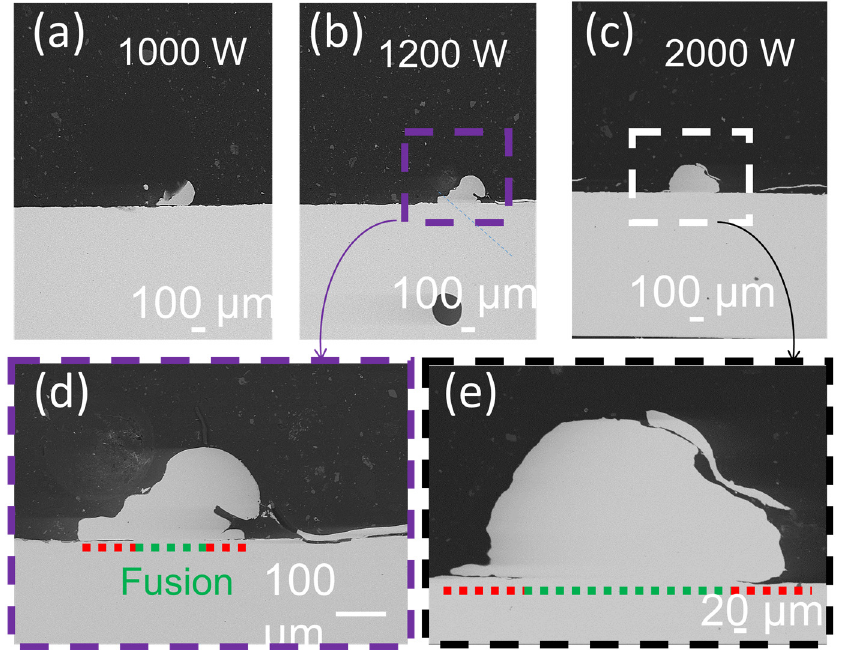
Figure 5. Pure copper cross-section welded bead SEM backscattered images for different laser power. ( a ) 1000 W, ( b ) 1200 W, ( c ) 2000 W. Zoom for ( d ) 1200 W and ( e ) 2000 W. The dotted lines indicate the fused zones in green and the not completely fused to the plate in red.